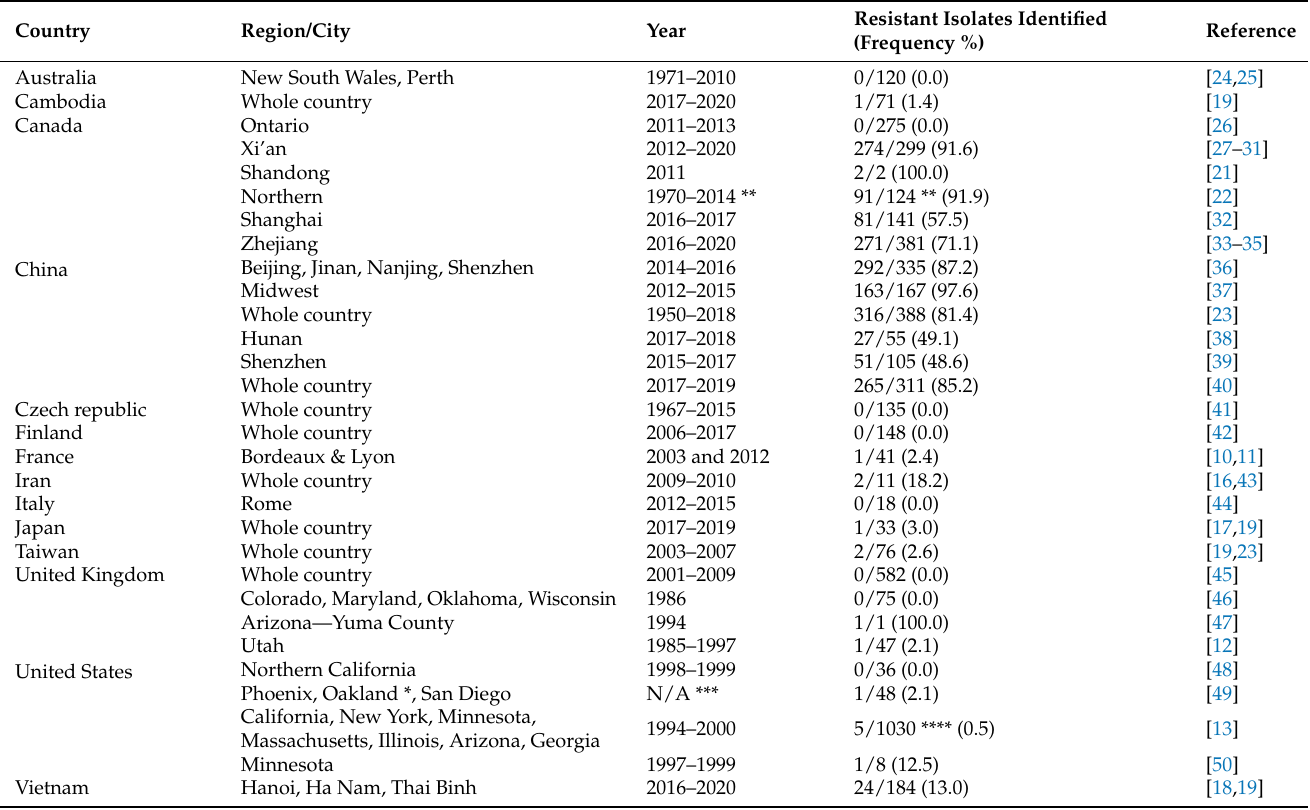
Table 1. Global frequencies of macrolide-resistant Bordetella pertussis